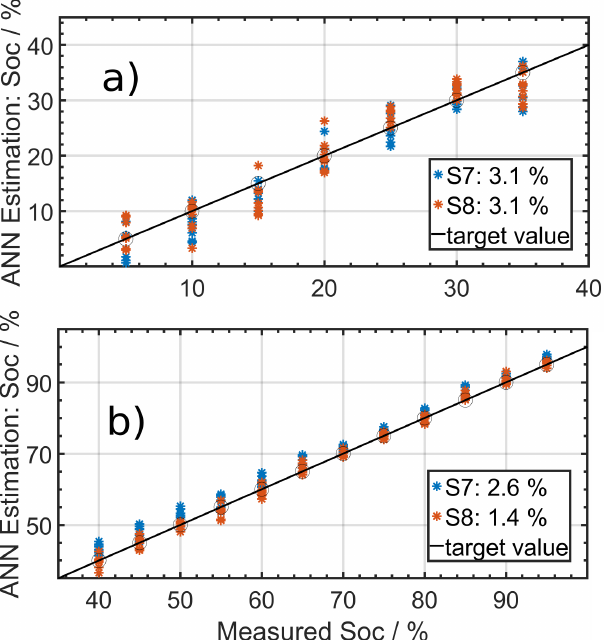
Figure 11. SoC estimation for Sony US18650VTC6 cells with an RMSE of about 3%. The SoC was split into ( a ) 5% to 35% and ( b ) 40% to 95% and estimated by individual neural networks. Overall, more than 300 SoC estimations are shown. The estimated SoC is plotted over the measured SoC. The black line is a guide to the eye of the target values. The legend shows the RMSE for each cell. The RMSE was increased for the estimation of lower SoCs because the impedance varies only slightly with low